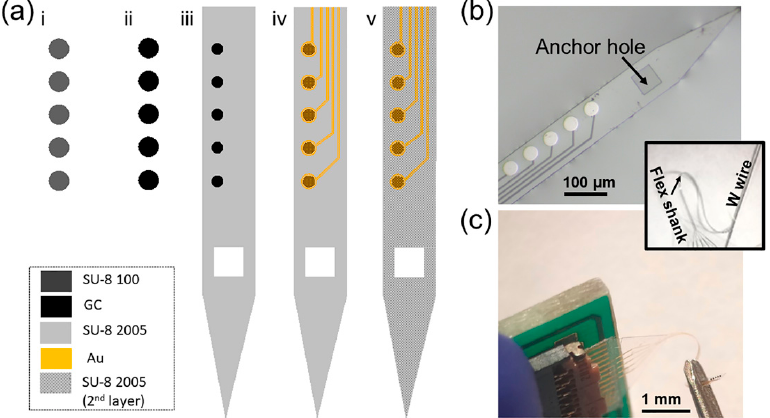
Figure 1. Flexible GC-coated hybrid MEA. ( a ) Schematic for fabrication of the GC MEAs: ( i ) SU-8 100 spin-coating and patterning of electrodes on SiO 2 wafer; ( ii ) pyrolysis; ( iii ) SU-8 insulation layer spin-coating on top of the GC electrodes and UV exposure to pattern the insulation layer and open a connection between the GC electrodes and the metal traces (next step) and the anchor hole; ( iv ) Metal deposition and patterning using a lift-off procedure; ( v ) SU-8 top insulation layer spin-coating and patterning of the probe outline and the anchor hole for the insertion of a 50 μ m tungsten shuttle. Finally, the probes were released from the silicon substrate using buffered oxide etchant (1:7) in acid hood. ( b ) Optical picture of a GC MEA on SU-8 substrate with a metal interconnection and GC microelectrodes, after the release from the wafer. In inset is reported a different view of the MEA flexible shank fabricated with an anchor hole at the shank tip to facilitate the insertion of a 50 μ m